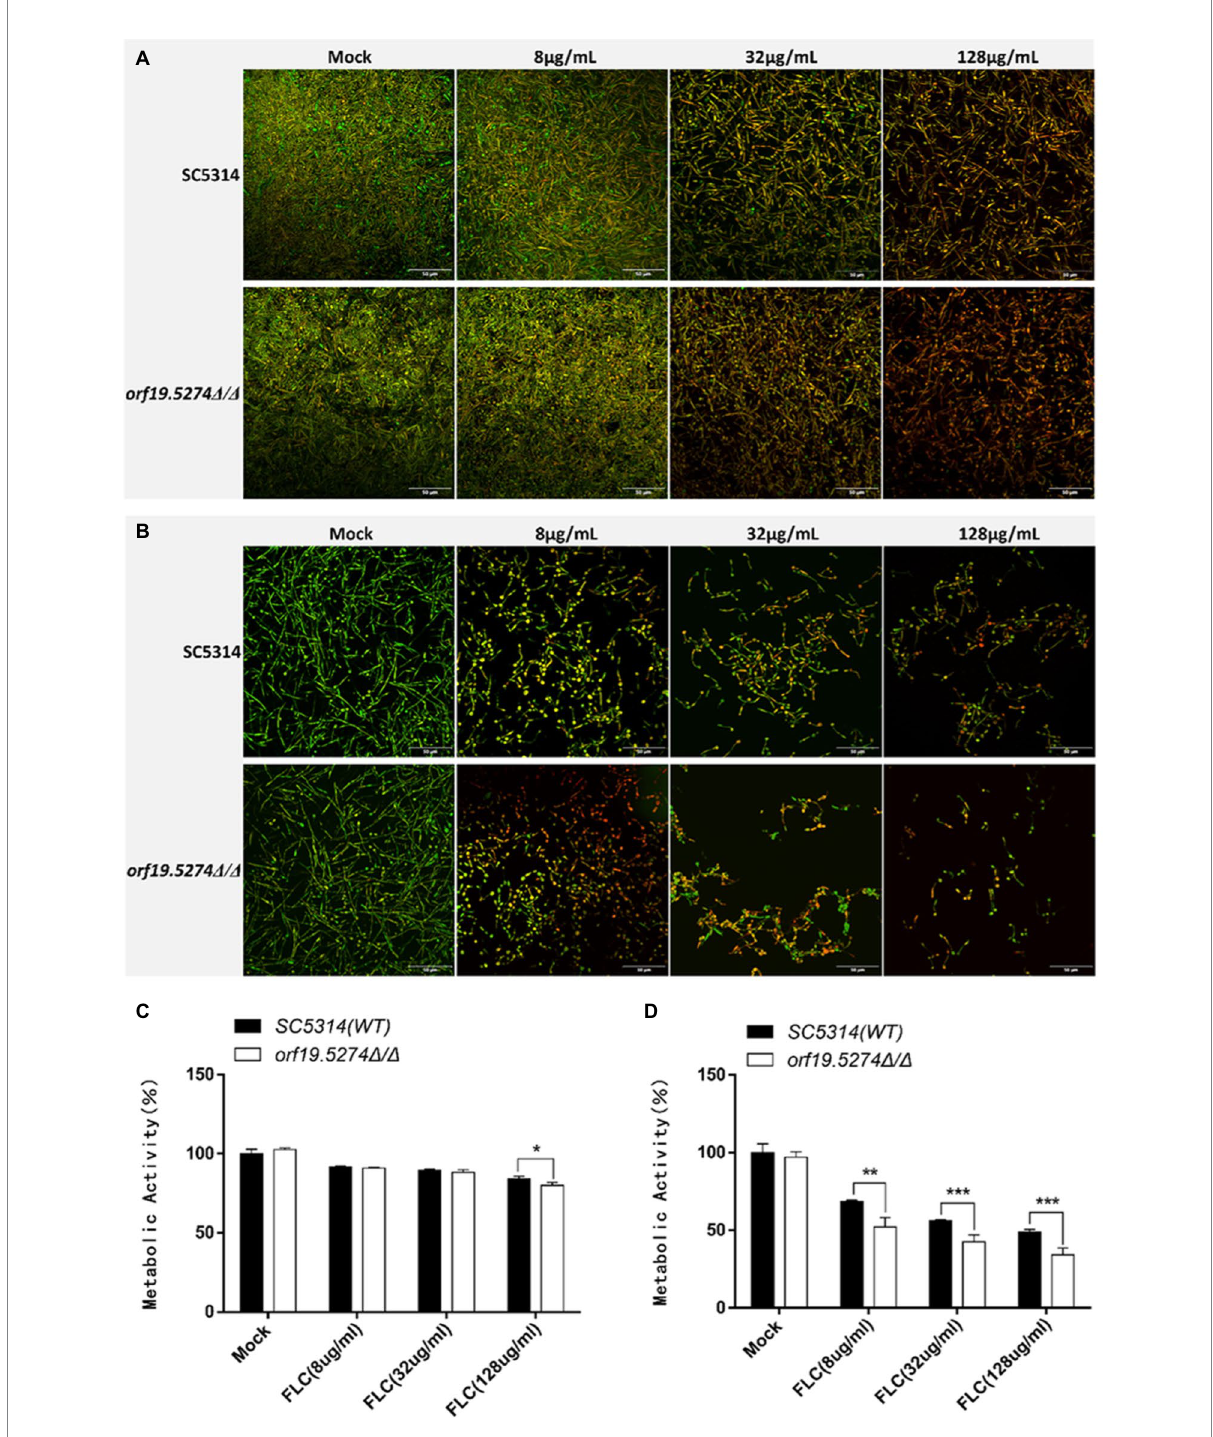
FIGURE 6 Effect of orf19.5274 Δ / Δ on Candida albicans biofilm. (A) CLSM images of mature biofilm treated with various FLC concentrations for 24 h. The biofilms were stained with viability indicators (SYTO9 and PI). Live cells stain green, and dead cells are red or yellow-colored. (B) CLSM images of biofilm formation after 24 h of co-culture with different concentrations of FLC and C. albicans ; (C) XTT assay to compare FLC’s metabolic activity in mature biofilm between mutant and wild strains. C. albicans cells were incubated in RPMI-1640 medium at 37 ° C for 24 h to form a mature biofilm. Next, the supernatant was discarded. (D) XTT assay to compare the metabolic activity of FLC in the biofilm formation process between mutant and wild strains. For biofilm formation, C. albicans cells were incubated with FLC (8 μ g/ml, 32 μ g/ml and 128 μ g/ml) in RPMI-1640 medium at 37 ° C for 24 h. XTT reduction was performed to determine the level of biofilm formation at various treatments, and colorimetric absorbance was measured at 490 nm. Error bars represent the standard deviation of four independent experiments. In comparison to the parent strain SC5314, * p < 0.05, ** p < 0.01, *** p <